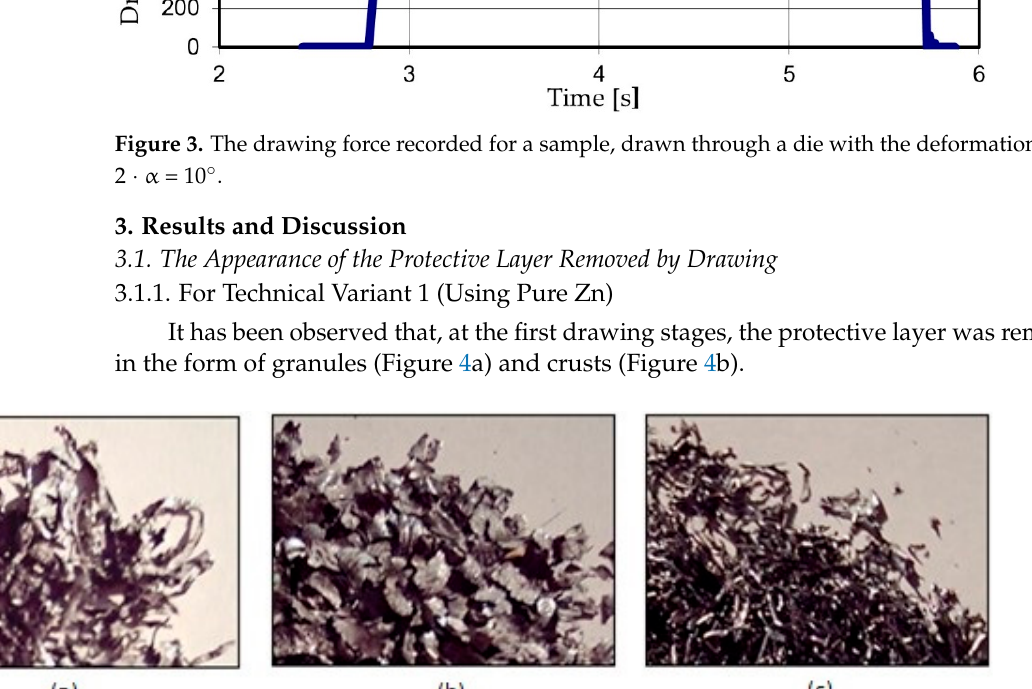
Figure 4. Ways that zinc was lost, obtained after steel wiredrawing: ( a ) granules; ( b ) crusts; ( c ) continued splinters.